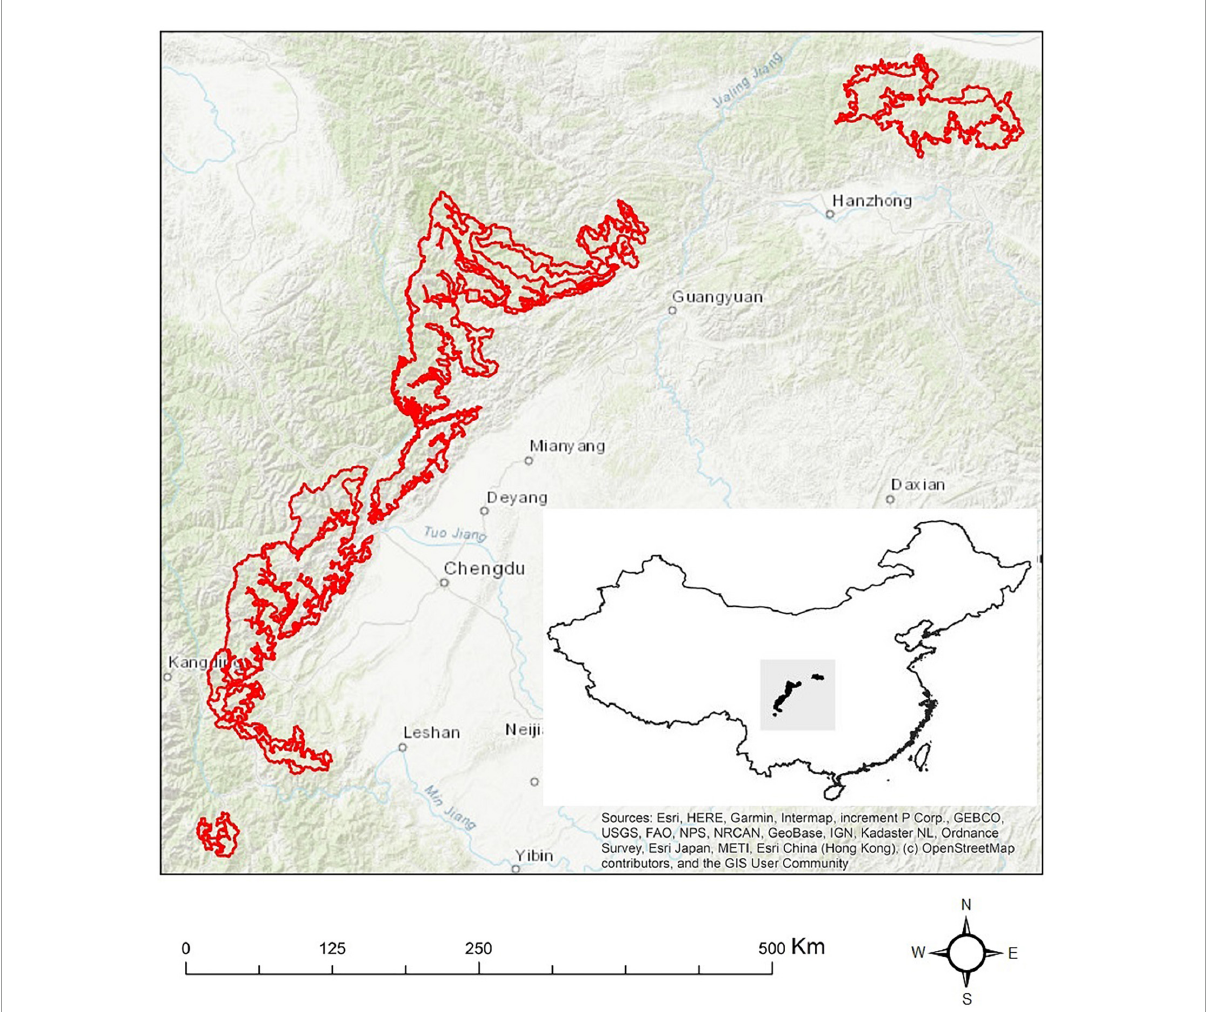
FIGURE1 Study area and its relative position in China (Hijmans, 2021) (inset). The red contour is the GPNP (Huang et al., 2020).